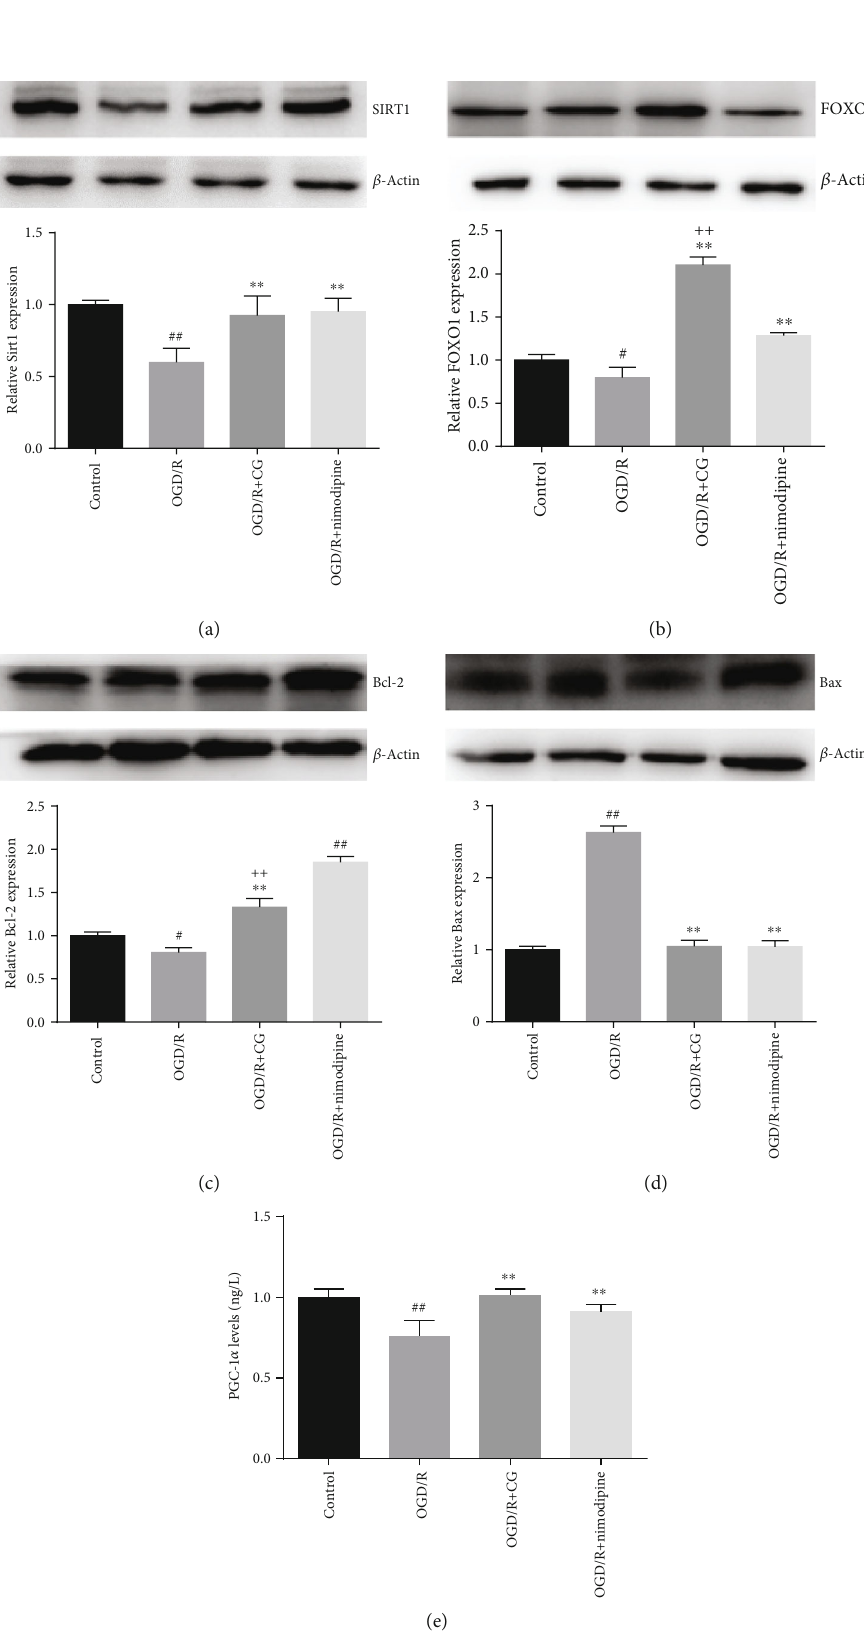
Figure 5: HT22 cells were treated with 8 h of OGD and then reoxygenated in the presence of CG for 6 h. Protein expression of SIRT1 (a), FOXO1 (b), Bcl-2 (c), and Bax (d) detected by Western blotting and PGC-1 α (e) detected by ELISA. Three independent experiments were performed, and data were expressed as the mean ± SD . # P < 0 : 05 , ## P < 0 : 01 vs. control group; ∗∗ P < 0 : 01 vs. OGD/R group; ++ P < 0 : 01 vs. nimodipine